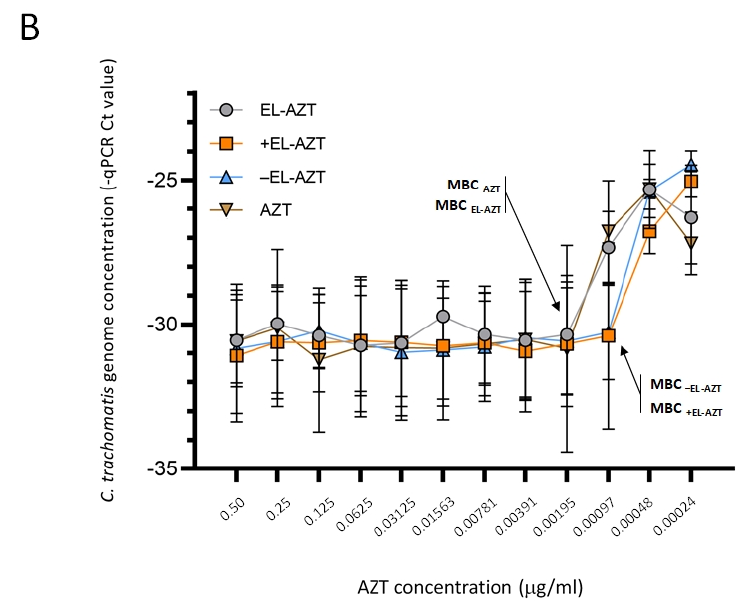
Figure 7. Impact of the AZT-liposomes on the growth of C. trachomatis serovar F clinical isolate. ( A ) Direct C. trachomatis growth in the presence of free AZT and encapsulated AZT. ( B ) Recoverable C. trachomatis growth. Data are mean − qPCR Ct levels ± S.D. ( n = 3). EL-AZT, neutral liposomes with azithromycin; +EL-AZT, cationic liposomes with azithromycin; − EL-AZT, anionic liposomes with azithromycin.